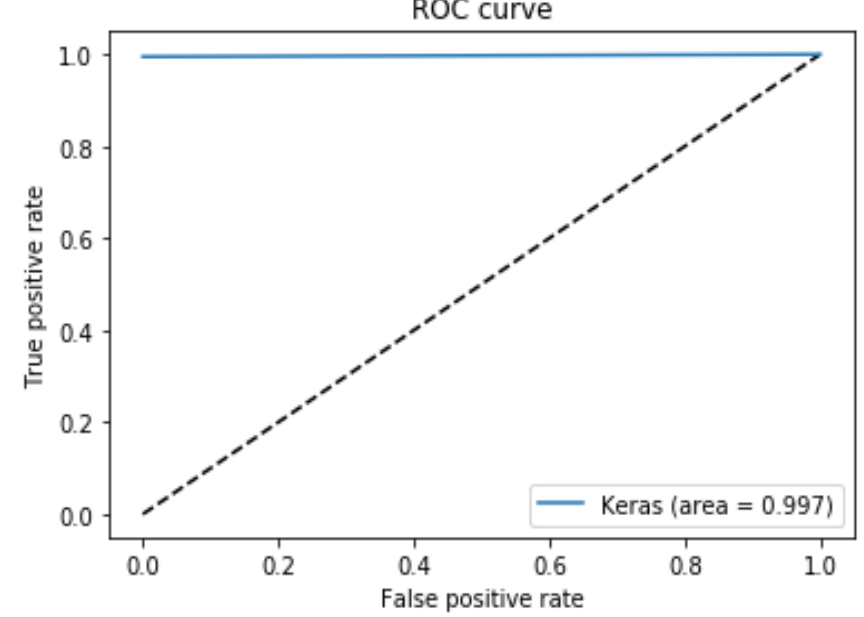
Figure 11: ROC curve for 80% training using BLSTM in time domain